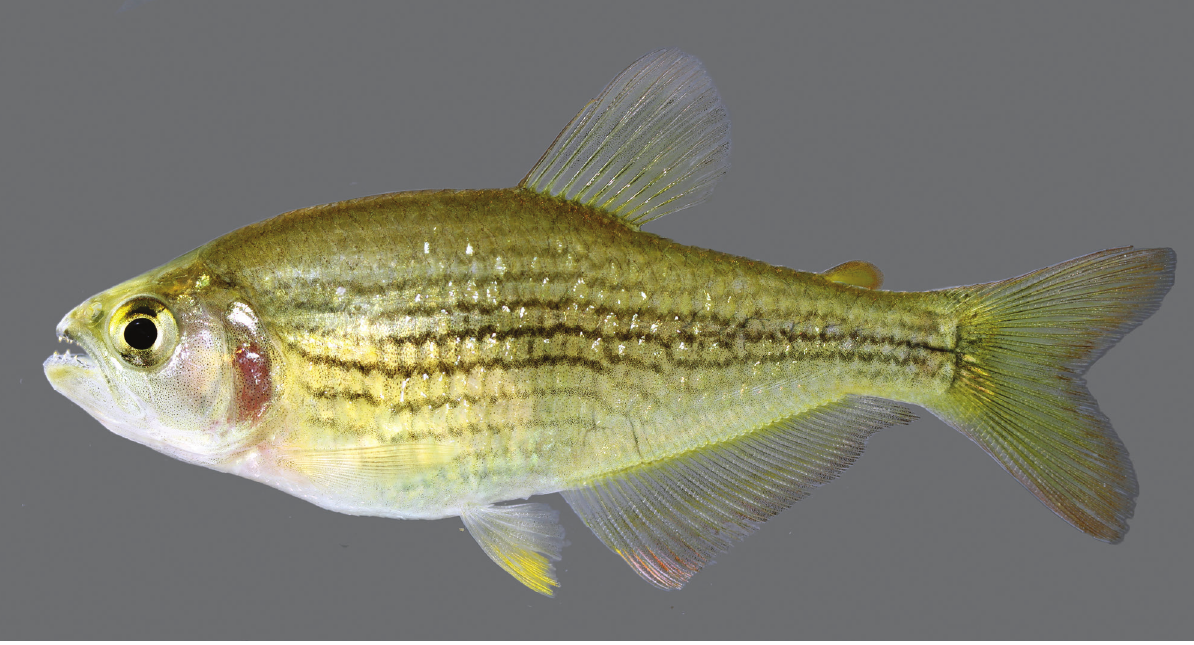
Fig. 3. Hollandichthys taramandahy , UFRGS 16513, paratype, male, 64.0 mm SL, lateral puddle of arroio Bananeiras, near the mouth of arroio da Barra, Itati, Rio Grande do Sul, Brasil. Live specimen.